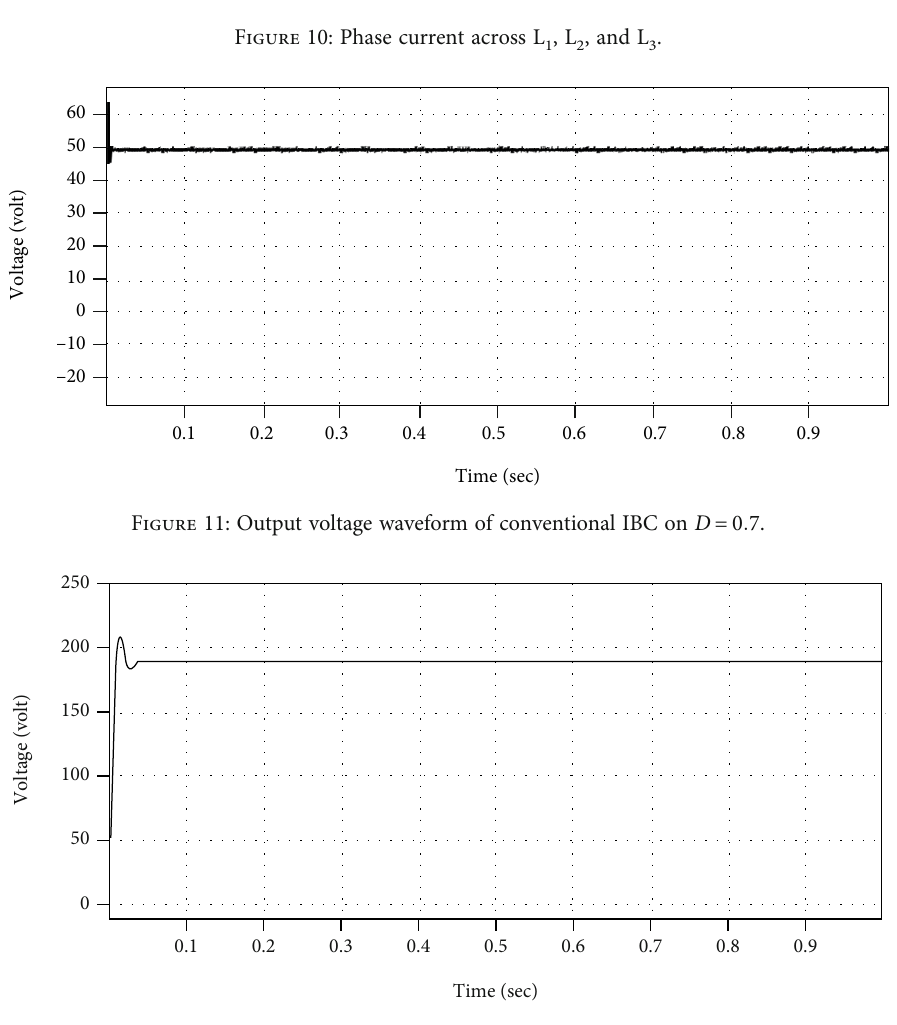
Figure 12: Output voltage waveform of conventional IBC on D = 0 : 925